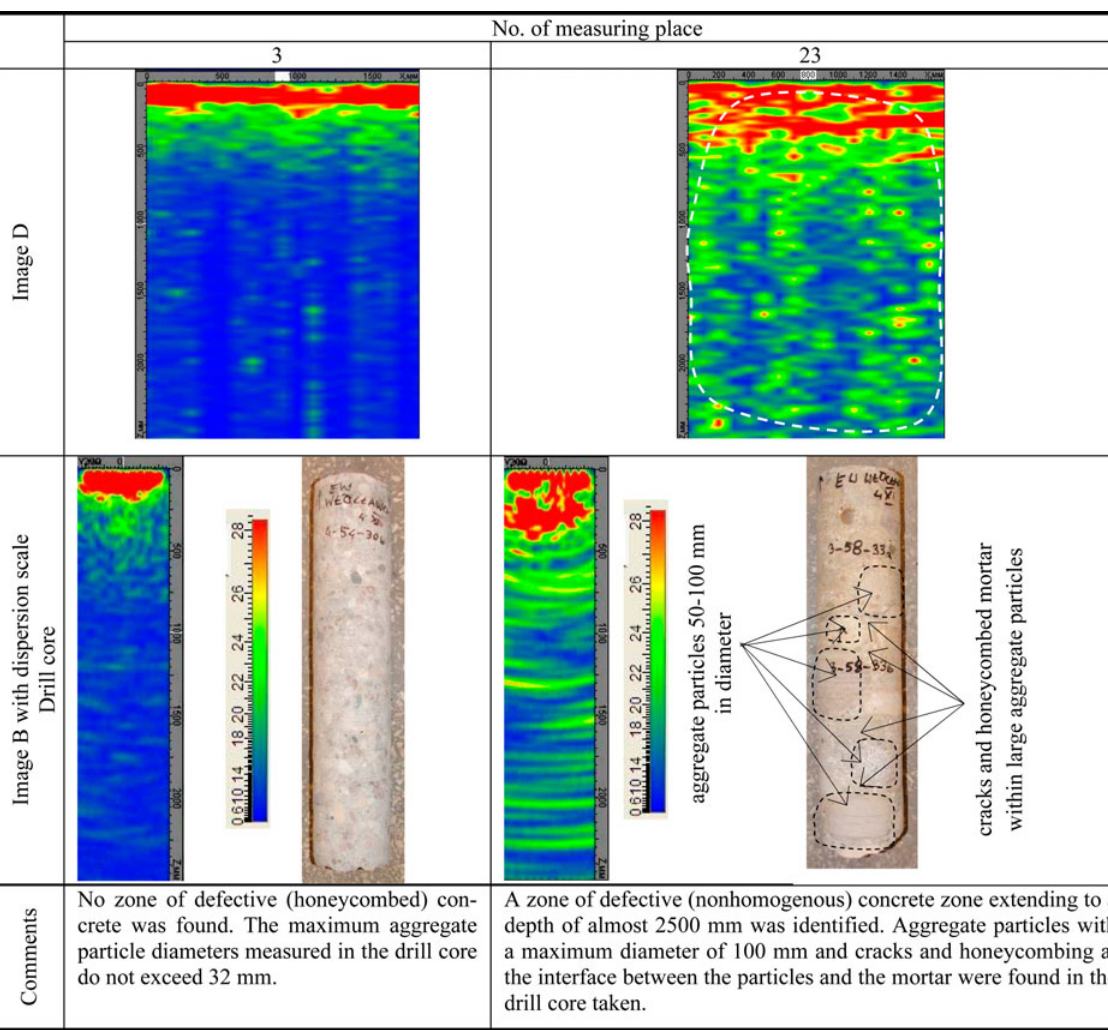
Table 3. On the basis of the parameter values in all the measuring points, maps showing the distribution of the parameter values were plotted. Sample maps for measuring points 3 and 23 are presented in Table